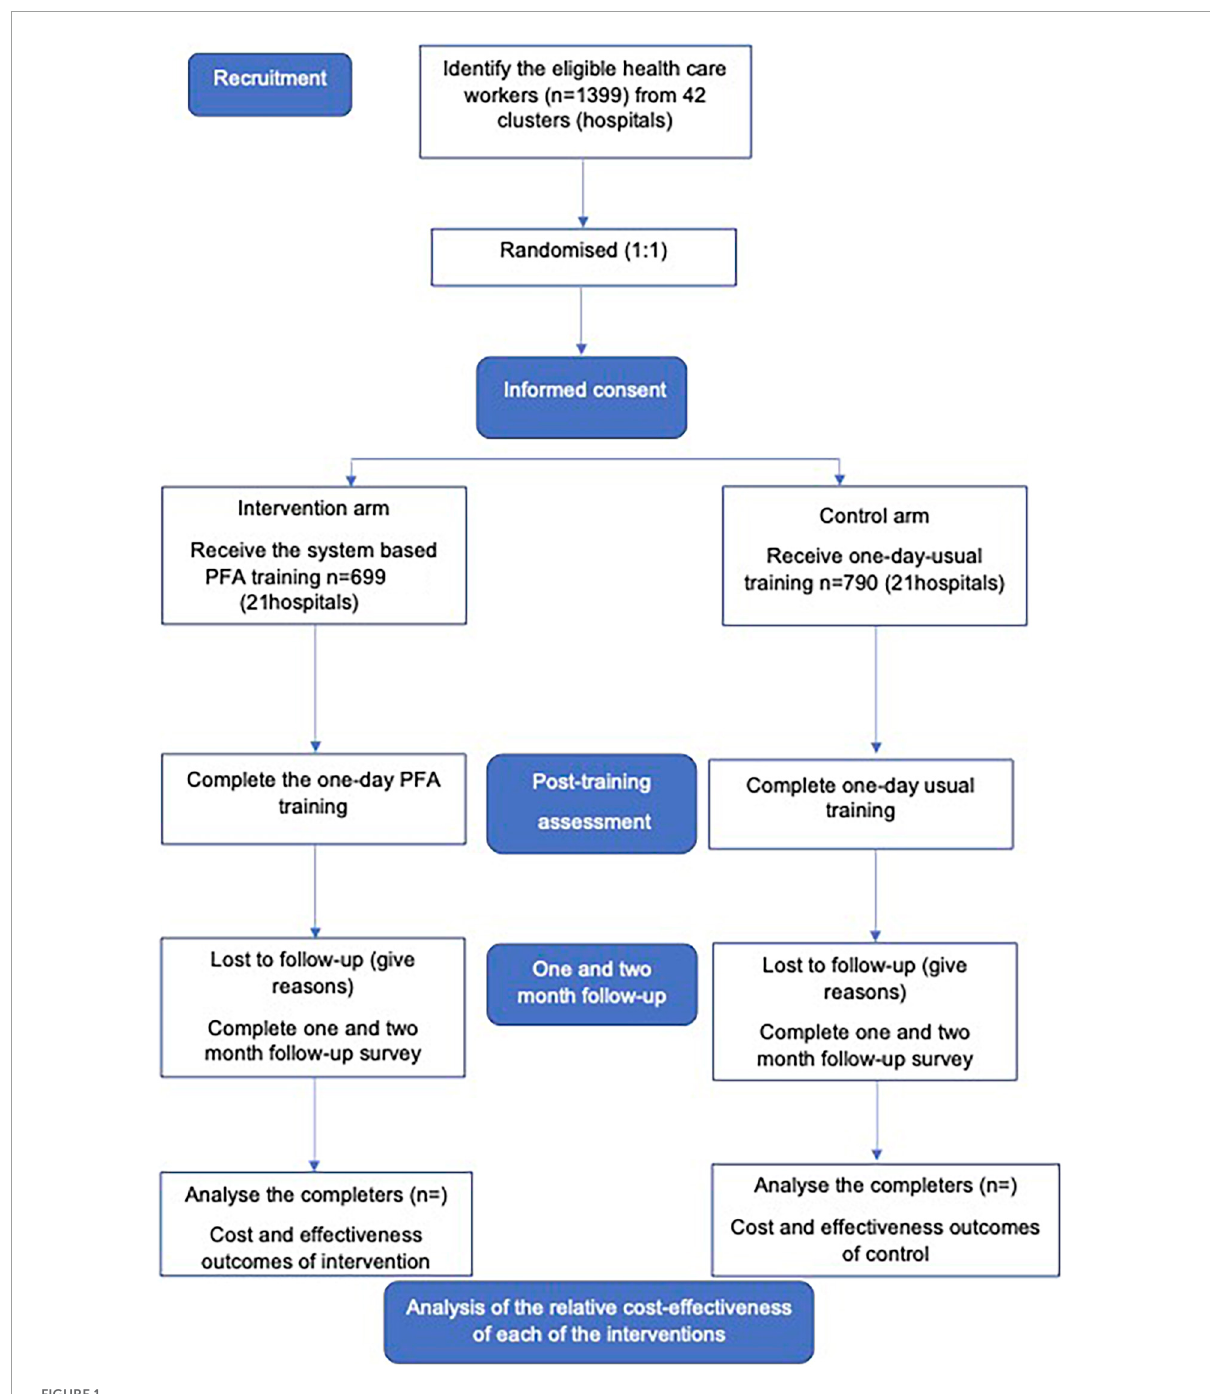
FIGURE1 Design and flow chart of participants through the trial.